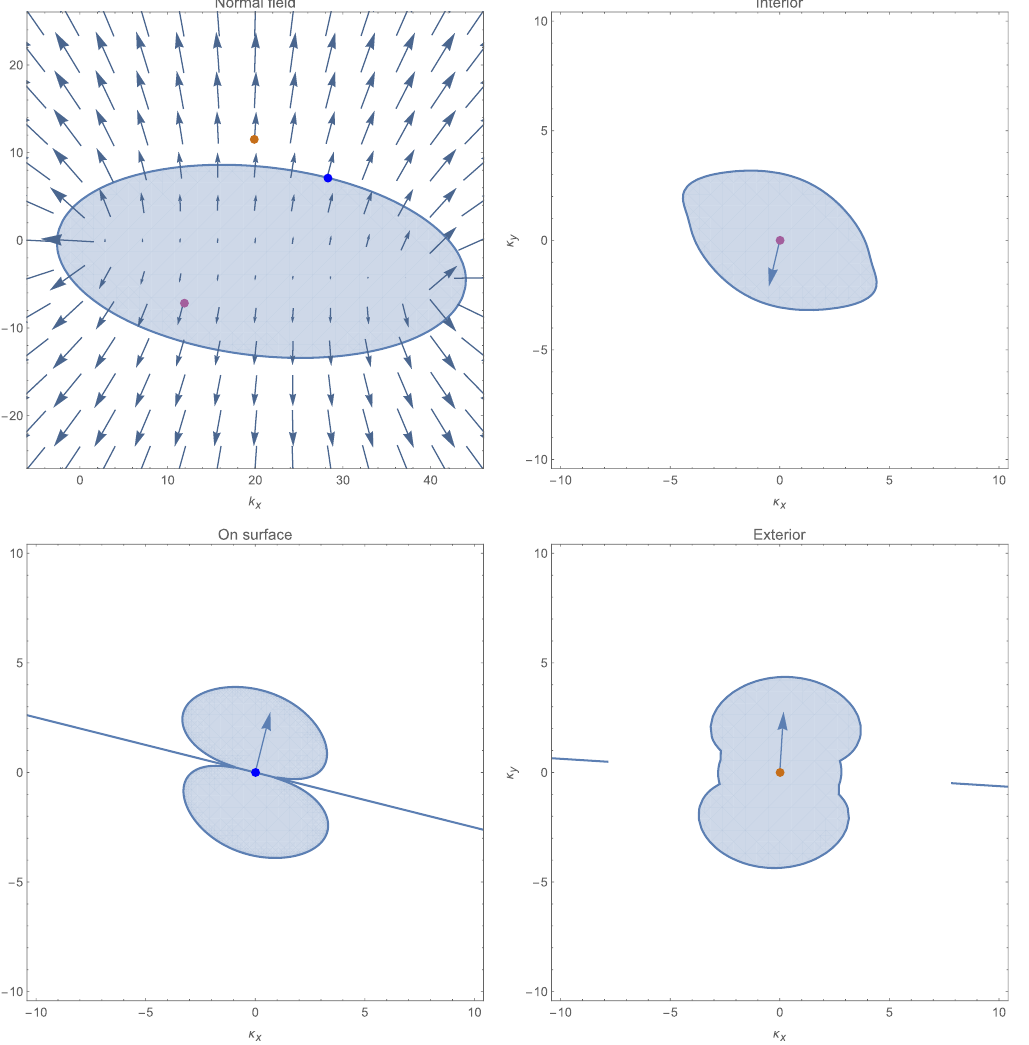
;~k x y ) space. Three points,